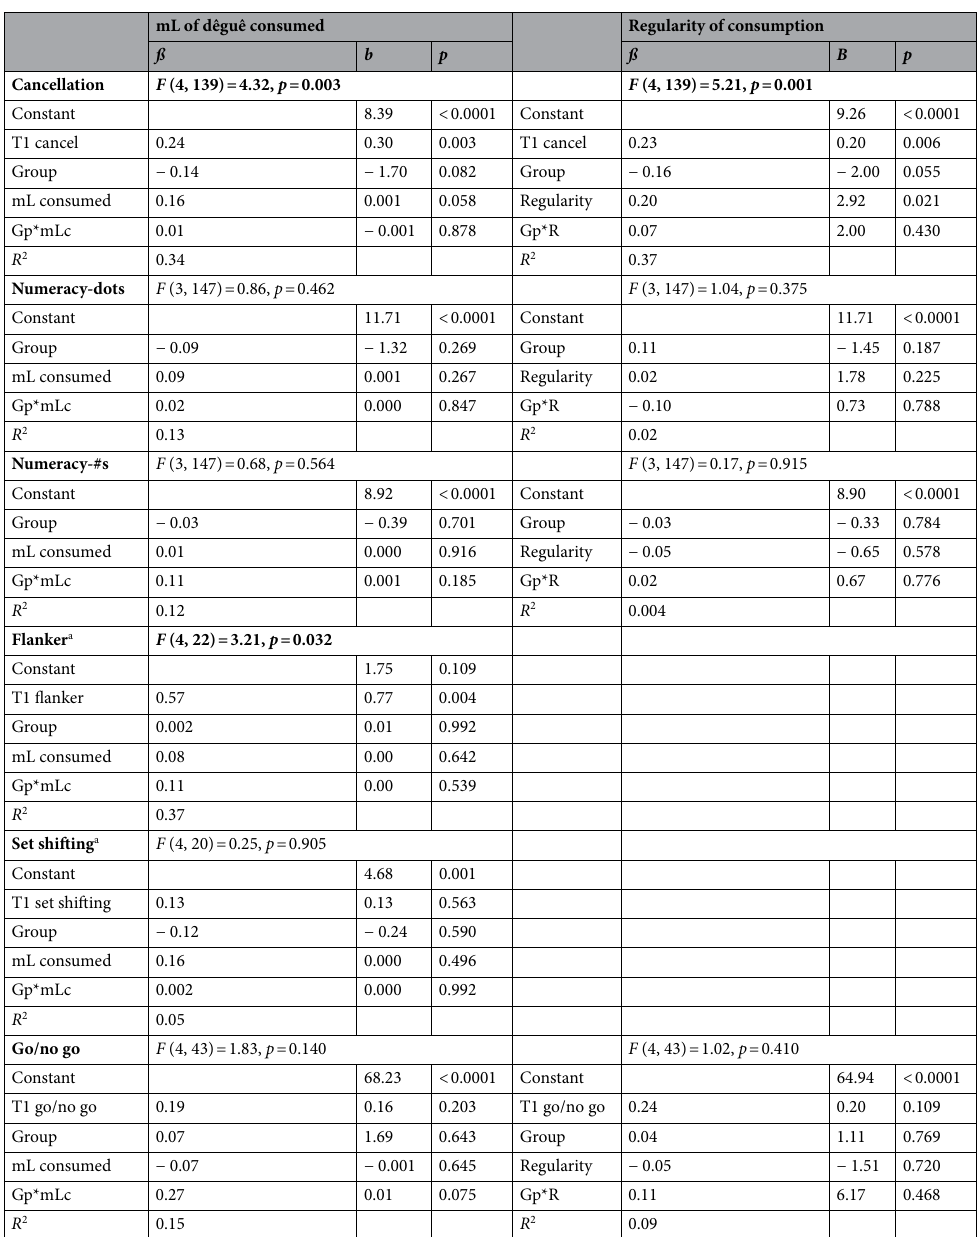
Table 4. Regression analyses predicting test scores from mL Dêguê consumed and regularity. ß = standardized regression coefficient; b = regression coefficient; R 2 = total variance explained by the model. #s = numbers. mL = milliliters. Gp*mLc = group by milliliters consumed interaction. Gp*R = group by regularity classification interaction. a Too few regular consumers to examine regularity effects. Significant models are